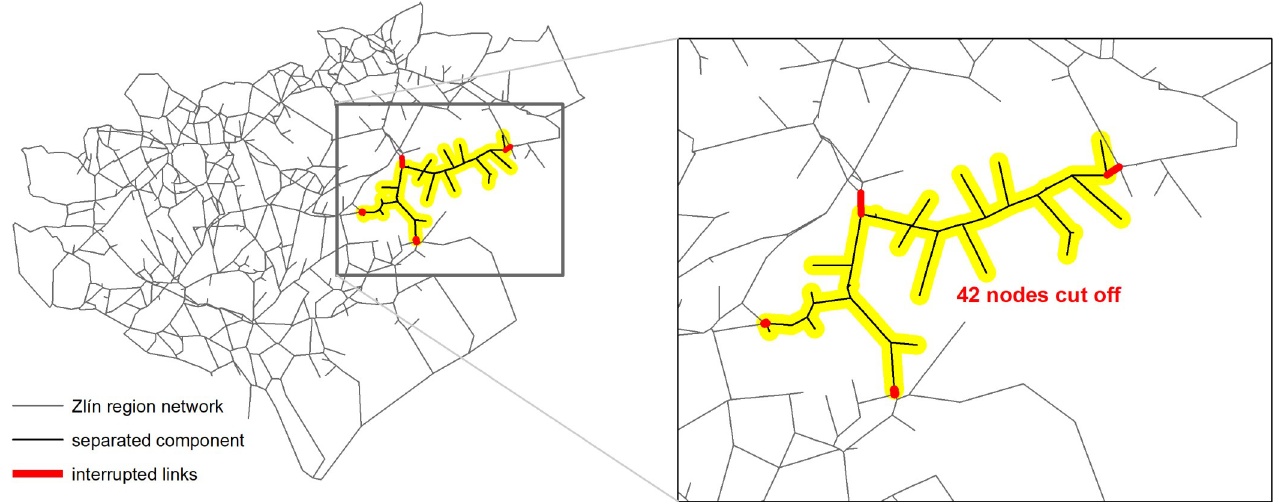
Fig 5. The second-worst-case scenario for the Zlı´n region. This network disintegration leaves 42 from the 731 nodes (5.7%) out of connection.